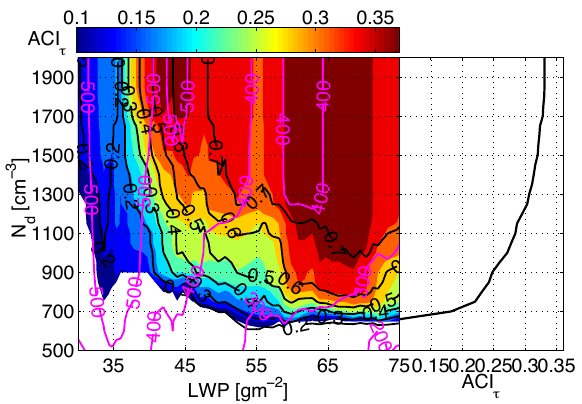
Figure 11: As in Figure 10, but for a 15-second LWP running mean. 1086 Fig. 11. As in Fig. 10, but for a 15-s LWP running mean.